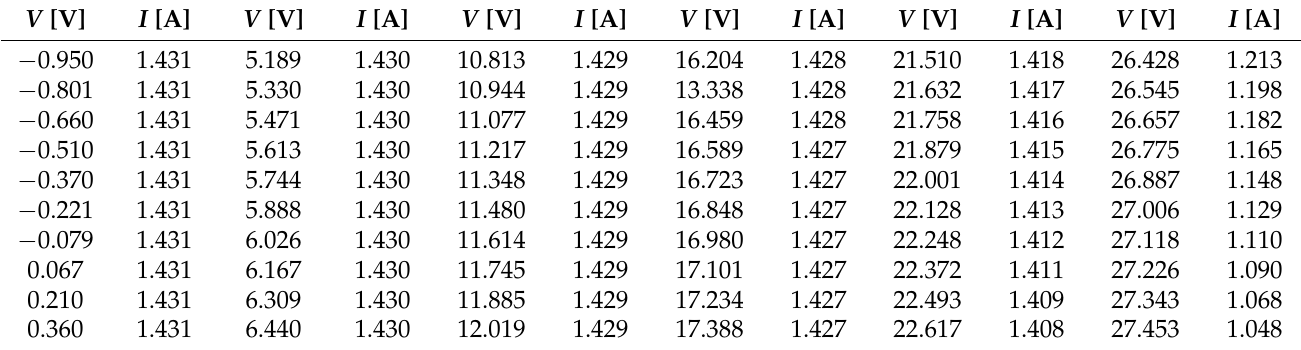
Table 1. I-V curve of the UPM-5 solar panel of the